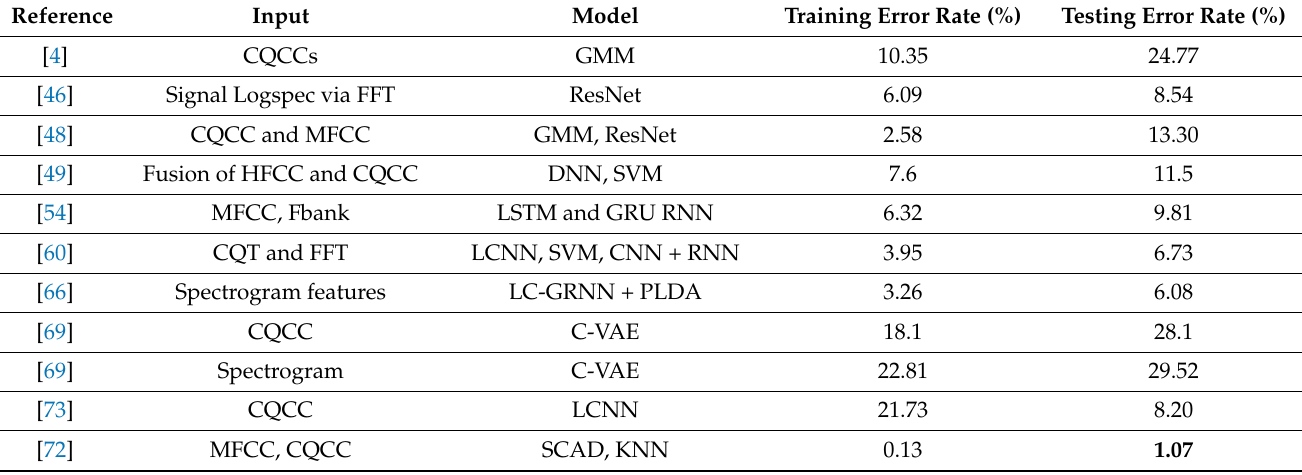
Table 1. State-of-the-art training and testing error rates when using the ASVspoof 2017 replay benchmark dataset.